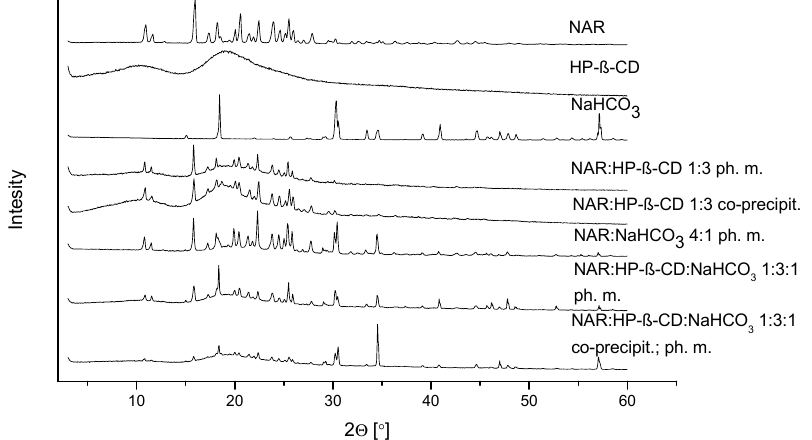
Figure 1. The XRPD diffraction patterns of NAR, HP- β -CD, NaHCO 3 , the binary system (NAR:HP- β -CD) obtained by the co-precipitation method, the physical mixtures (NAR:HP- β -CD; NAR:NaHCO 3 ), the ternary system (NAR:HP- β -CD:NaHCO 3 ), and the physical mixture (NAR:HP- β -CD:NaHCO 3 ).